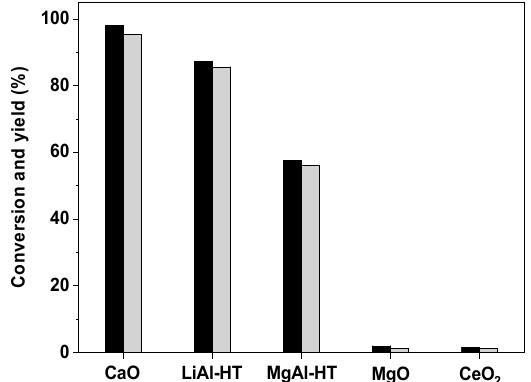
cyclopentanone [45]. Scheme 1. Synthetic strategies for the production of C 15 cycloalkanes with furfural and